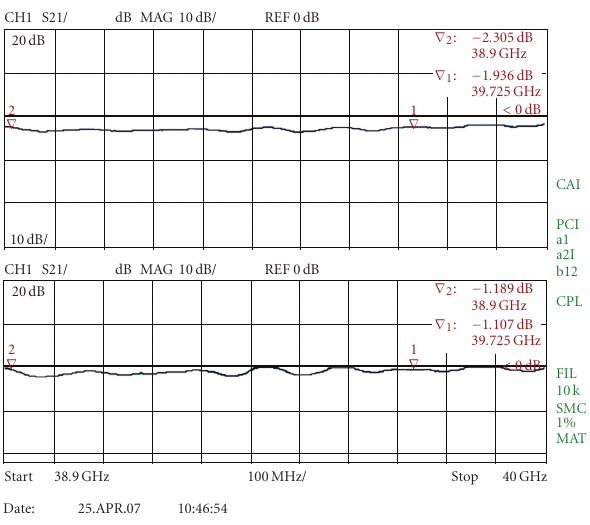
Figure 4: Insertion loss imbalance of the balanced BPSK modula- tor.